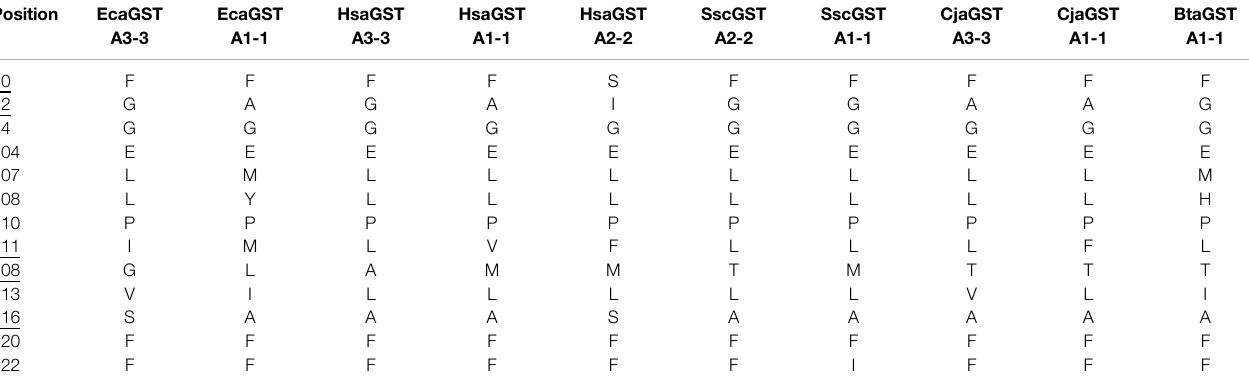
TABLE 1| Aminoacidresidues in theH-site ofsomemammalian GSTs.Speciesdesignations: Bta, Bostaurus (cow);Cja, Callithrix jacchus (common marmoset); Clu, Canis lupus (dog); Eca, Equus caballus (horse); Hsa, Homo sapiens (man); Ssc, Sus scrofa (pig). Five positions judged to govern ketosteroid isomerase activity based on mutational studies (Johansson and Mannervik, 2002; Pettersson et al., 2002) are underlined.